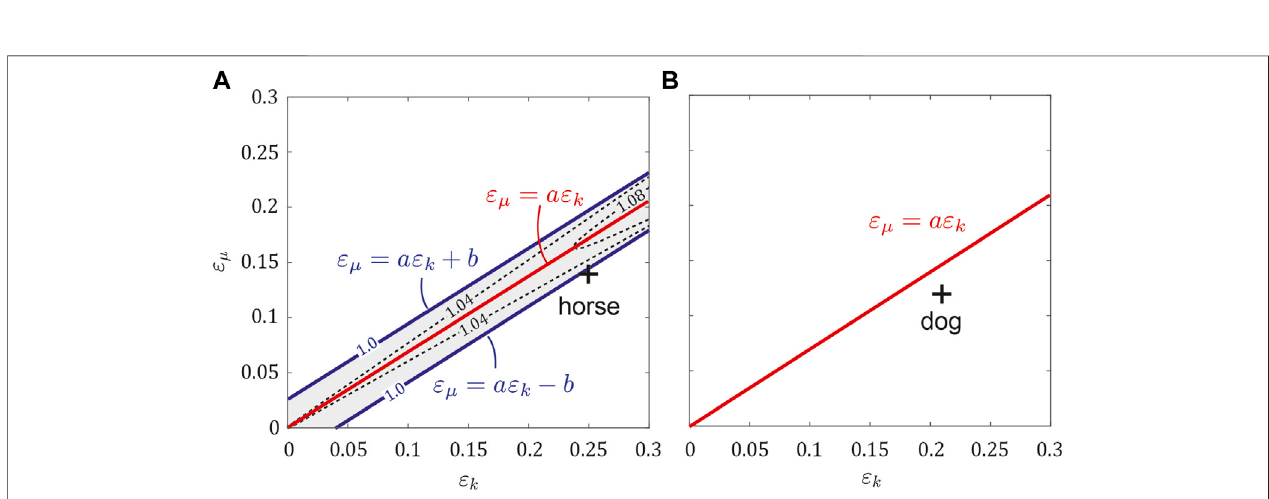
FIGURE 5 | Stability of periodic solutions for ε μ and ε k . Contour of the maximum eigenvalue Λ in the (A) horse model and (B) dog model. White and gray regions indicate the stable and unstable regions, respectively. ε μ = a ε k ± b corresponds to the boundary of Λ = 1. b > 0 in the horse model, whereas b = 0 in the dog model. Crosses indicate the estimated values of ε μ and ε k in